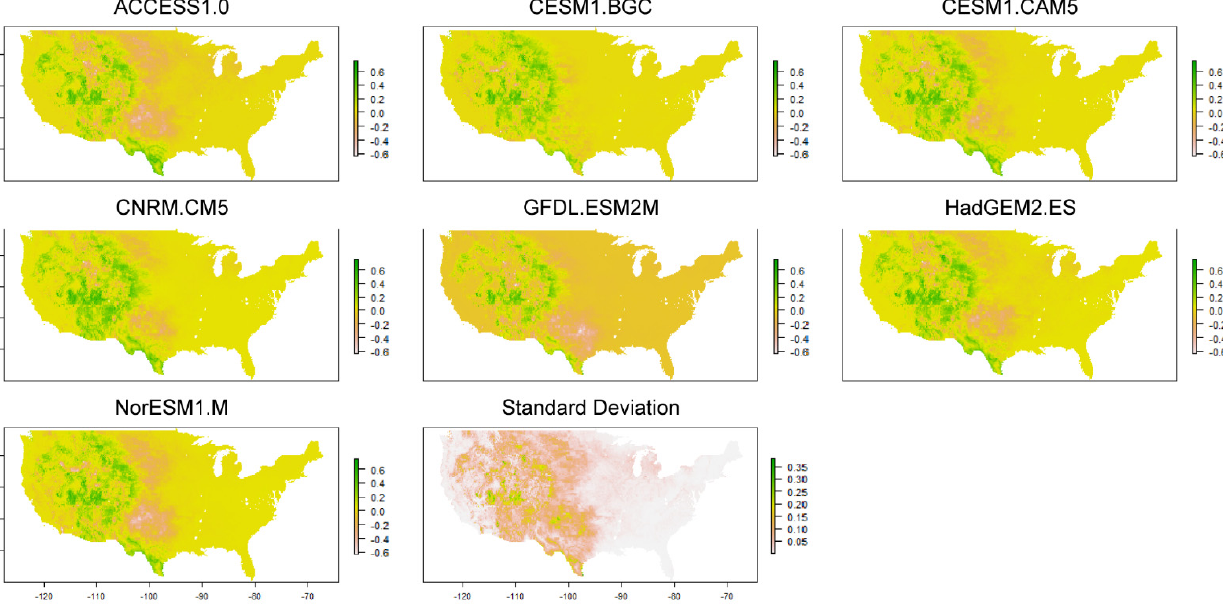
Figure A7. As Figure A6, except using climate projections from the RCP 8.5 emission scenario.